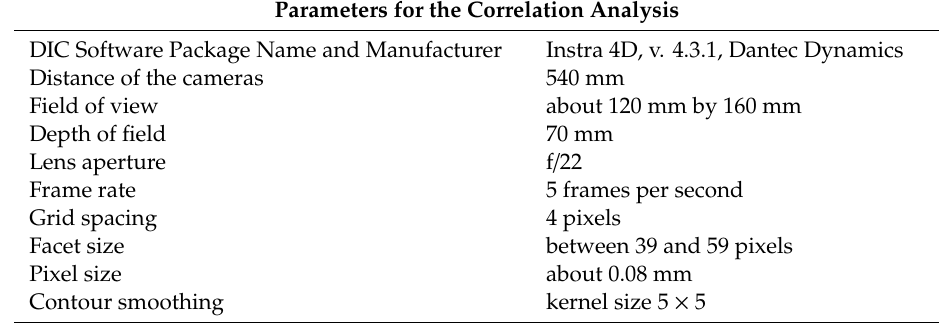
Table 2. Details of the parameters used for the correlation analysis with the DIC system (according to